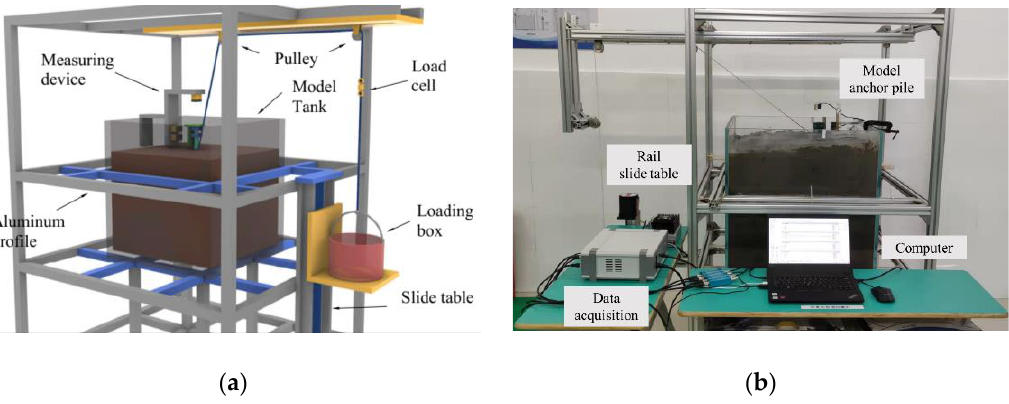
Figure 2. Schematic diagram ( a ) and photo ( b ) of the cyclic loading experimental setup.